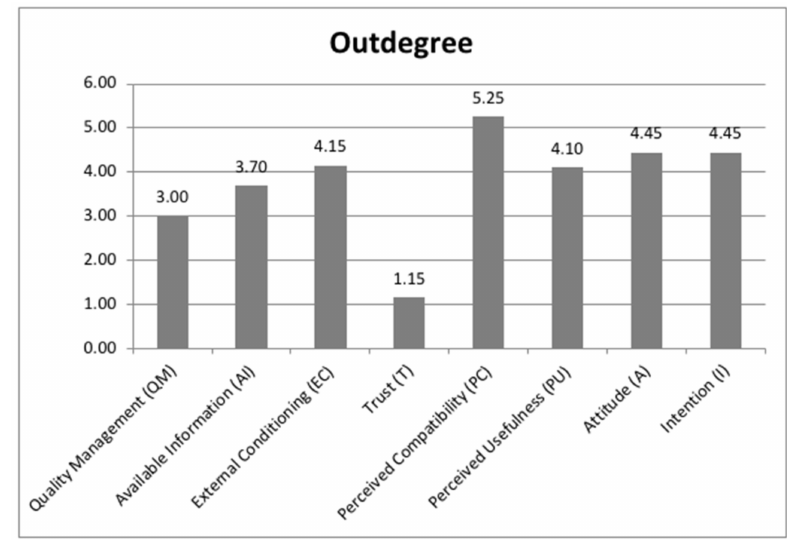
Figure 1. Indicators of the fuzzy cognitive map: outdegree. The software gave the highest value (5.25) to perceived compatibility (PC) and the lowest value (1.15) to trust (T); the rest of the factors were found above the average of these two (3.20), minus the quality management (QM) factor (3.00). These values were used to measure the degree of influence that a factor exerts on the others and were calculated from the evaluations given by the degree of causal relationships provided by the experts Regarding the indegree indicator, the classification of these factors from highest to lowest was perceived usefulness (PU), intention (I), attitude (A), external conditioning (EC), available information (AI), perceived compatibility (PC), trust (T) and quality management (QM) (Figure 2). This classification is independent of the previous classification, and its values were only given by the degree of causal relationships provided by the experts.